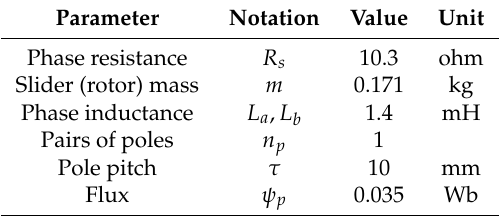
Table 1. Parameters of the Polysolenoid Linear Motor